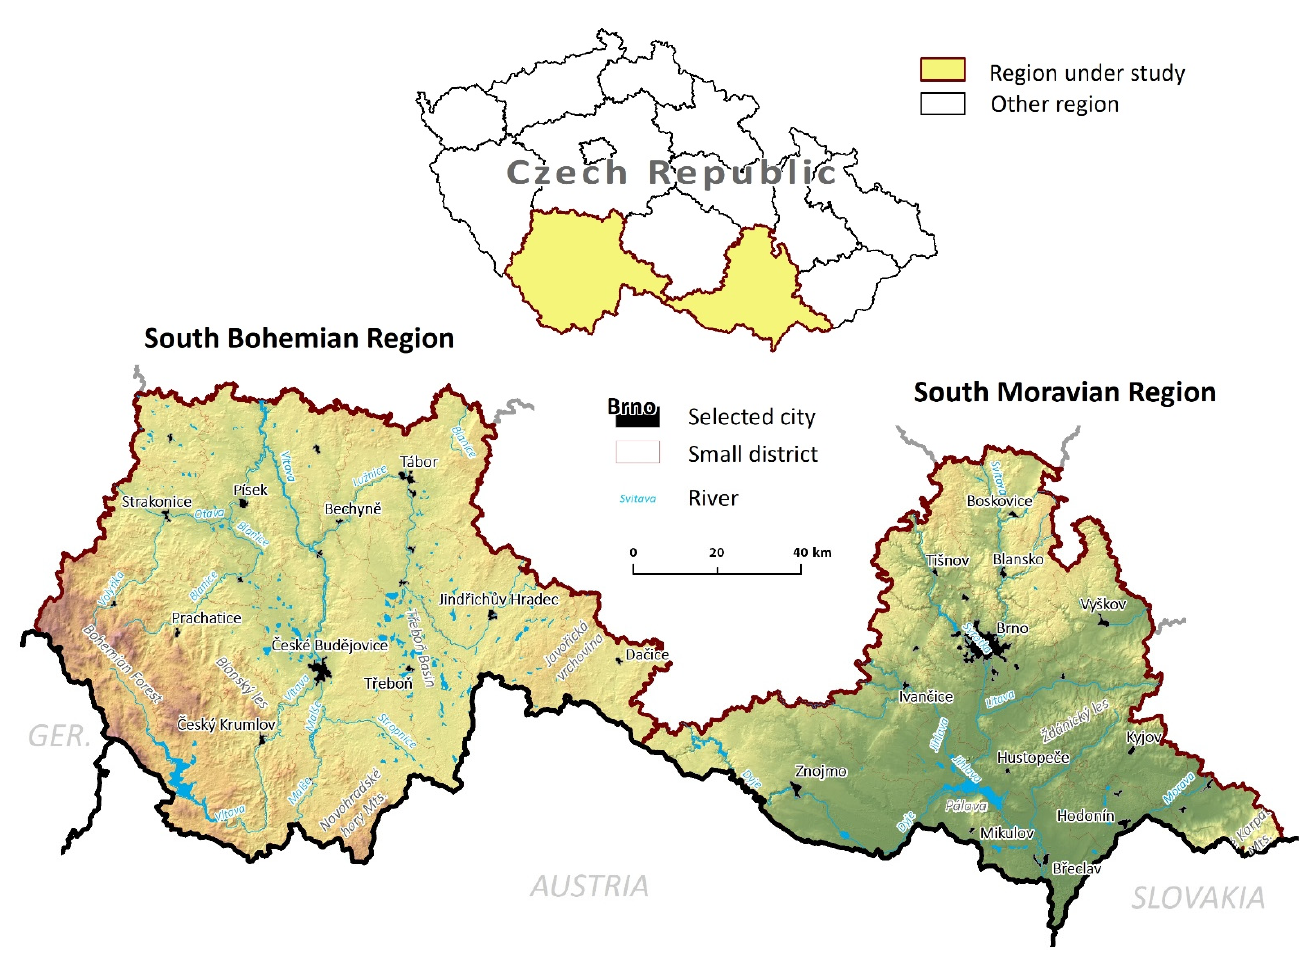
Figure 1. Study area.